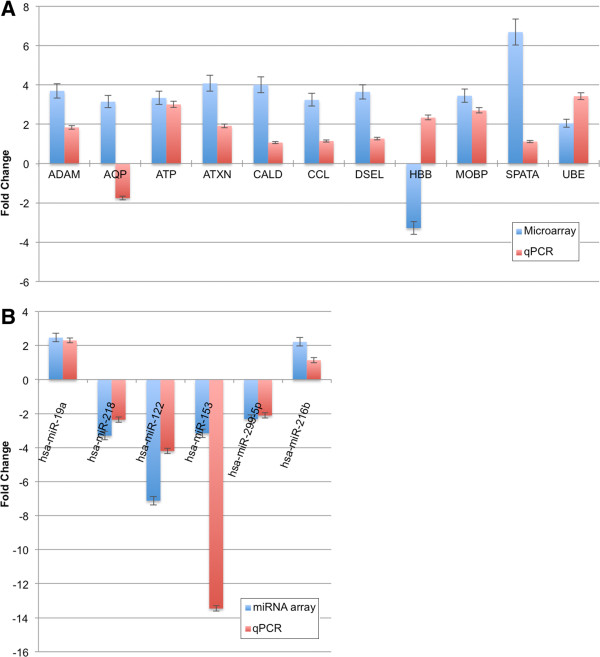
Validation of mRNA and miRNA profiles using quantitative RT-PCR on the same sample set of microarray study. A. mRNA profiles validation. B. miRNA profiles validation. Data was analysed using the 2-ΔΔCt method and results were plotted as fold differences of relative expression normalized to house keeping gene (GAPDH) and Hs_RNU6B_3 individually. The data have been collected from the same RNA samples from which mRNA and miRNA profiling have been done. All the data presented in this figure have significant P value of <0.05 as calculated by Student's t-test.